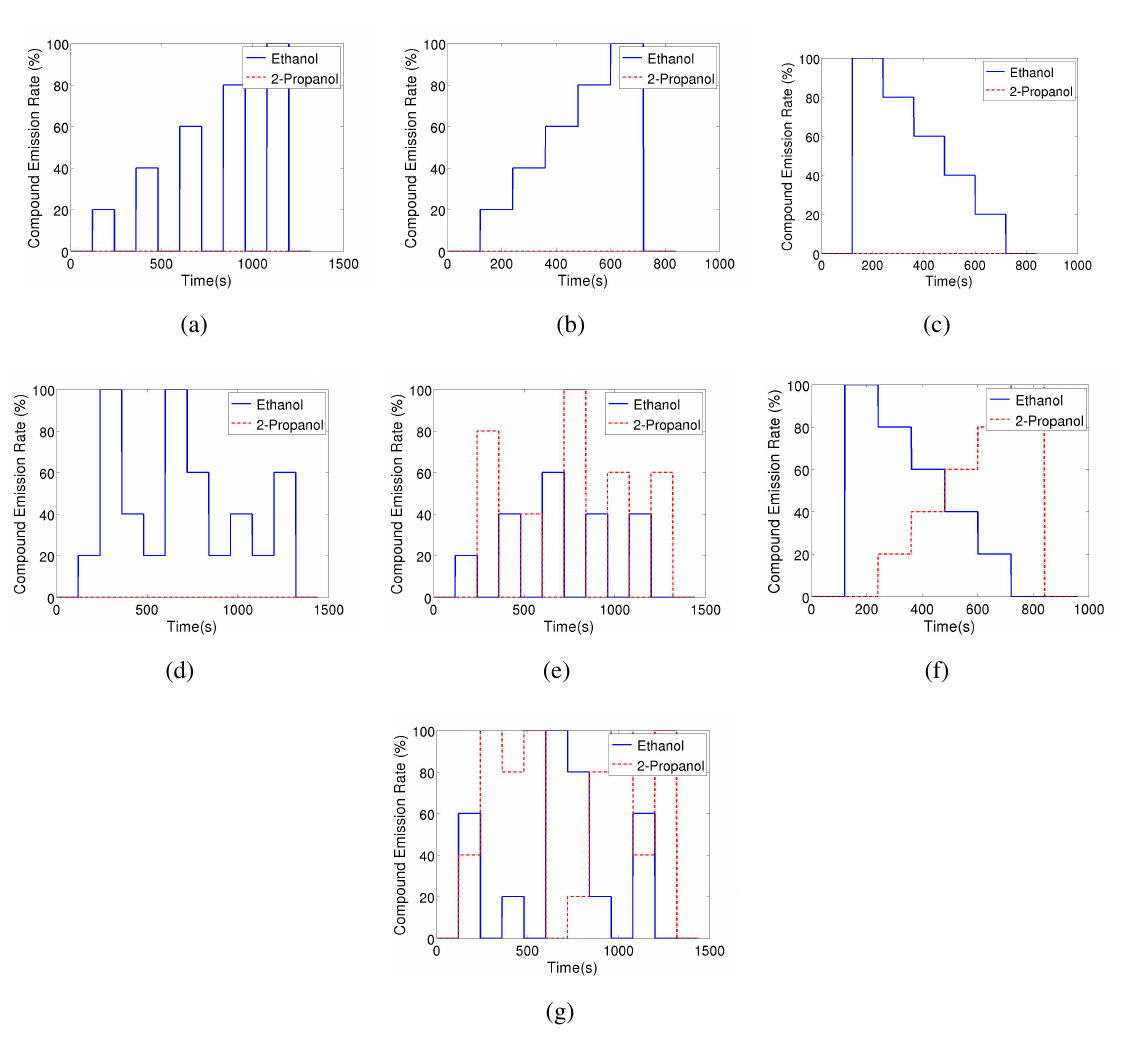
Figure 3. Gas source emission strategies. Strategies ( a – d ) are displayed only for ethanol (they are repeated identically also with 2-propanol as target gas). For the randomized strategies, i.e. , ( d ), ( e ), and ( g ) one exemplary instance is displayed. (a) Steps; (b) Ascending Stairway; (c) Descending Stairway; (d) Random Stairway; (e) Random